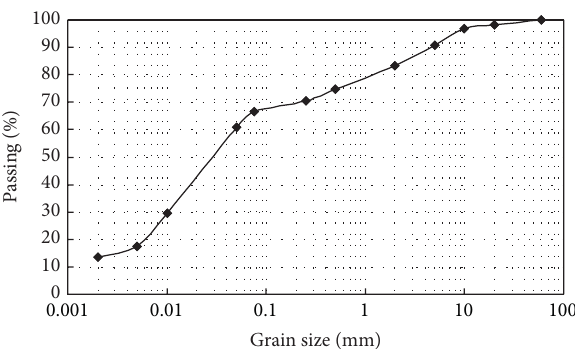
Figure 4: Grain size distribution curve for the slip zone